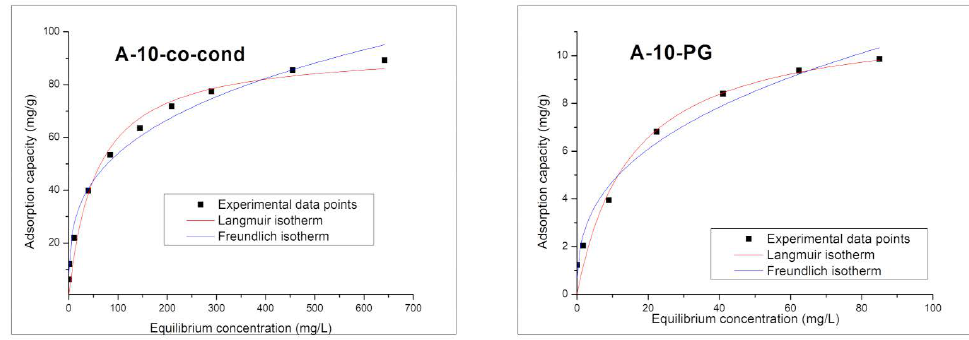
Figure 13. Adsorption isotherms for the A-10-co-cond ( left ) and A-10-PG ( right ) samples. The highest value for the regression coefficient, R 2 , was obtained using the Langmuir (~0.99) model, therefore, we may conclude that the removal process of Cr(VI) by adsorption onto the two materials is better described by the Langmuir model. The A-10-co-cond material has the maximum adsorption capacity of 93.6 mg/g, obtained by fitting the experimental data using the Langmuir model while for the A-10-PG the fitted adsorption capacity is 11.5 mg/g. The maximum adsorption capacity experimentally determined is 85.4 mg/g for A-10-co-cond sample and 9.4 mg/g for the A-10-PG sample, very close to the theoretical values determined by Langmuir model, proving that this model describes the best the adsorption process. The A-10-co-cond has higher affinity for Cr(VI) ions compared to the A-10-PG material.